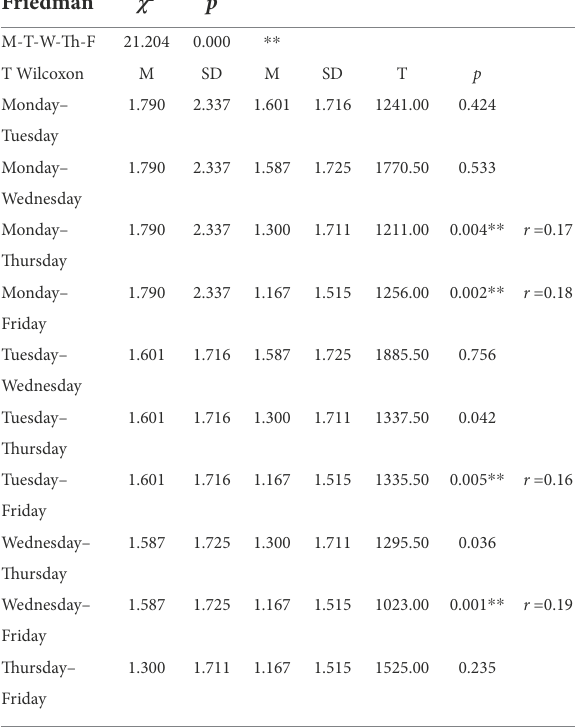
TABLE 5 Results of Friedman’s test and multiple a posteriori contrasts of conflicts at home in the morning during weekdays. Comparison parents days of the week morning